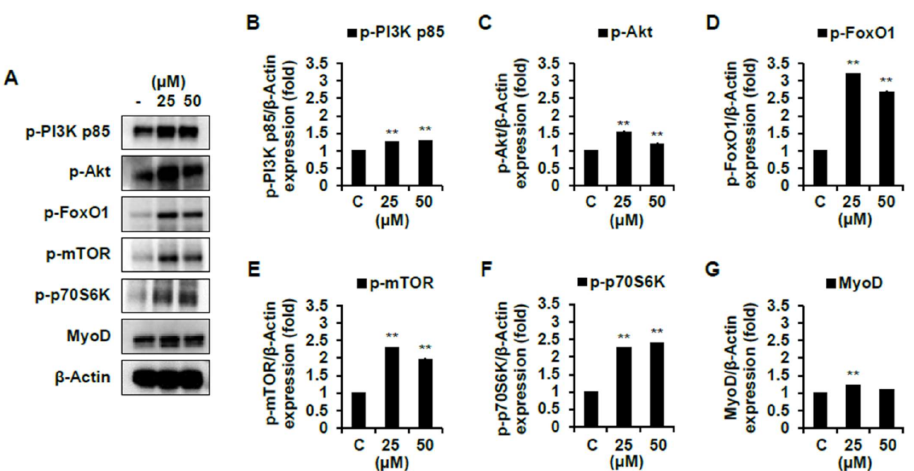
Figure 8. Skeletal muscle cell differentiation activity of compound 7 on C2C12 differentiated cells. The levels of p-PI3K p85, p-Akt, p-FoxO1, p-mTOR, p-p70S6K, and MyoD proteins were determined using a Western blot analysis. Every level of proteins versus β -Actin were measured by densitometry. C, control. Experiments were performed in triplicate and the data are expressed as mean ± SE; ** p < 0.01 as compared to the control (untreated cells).